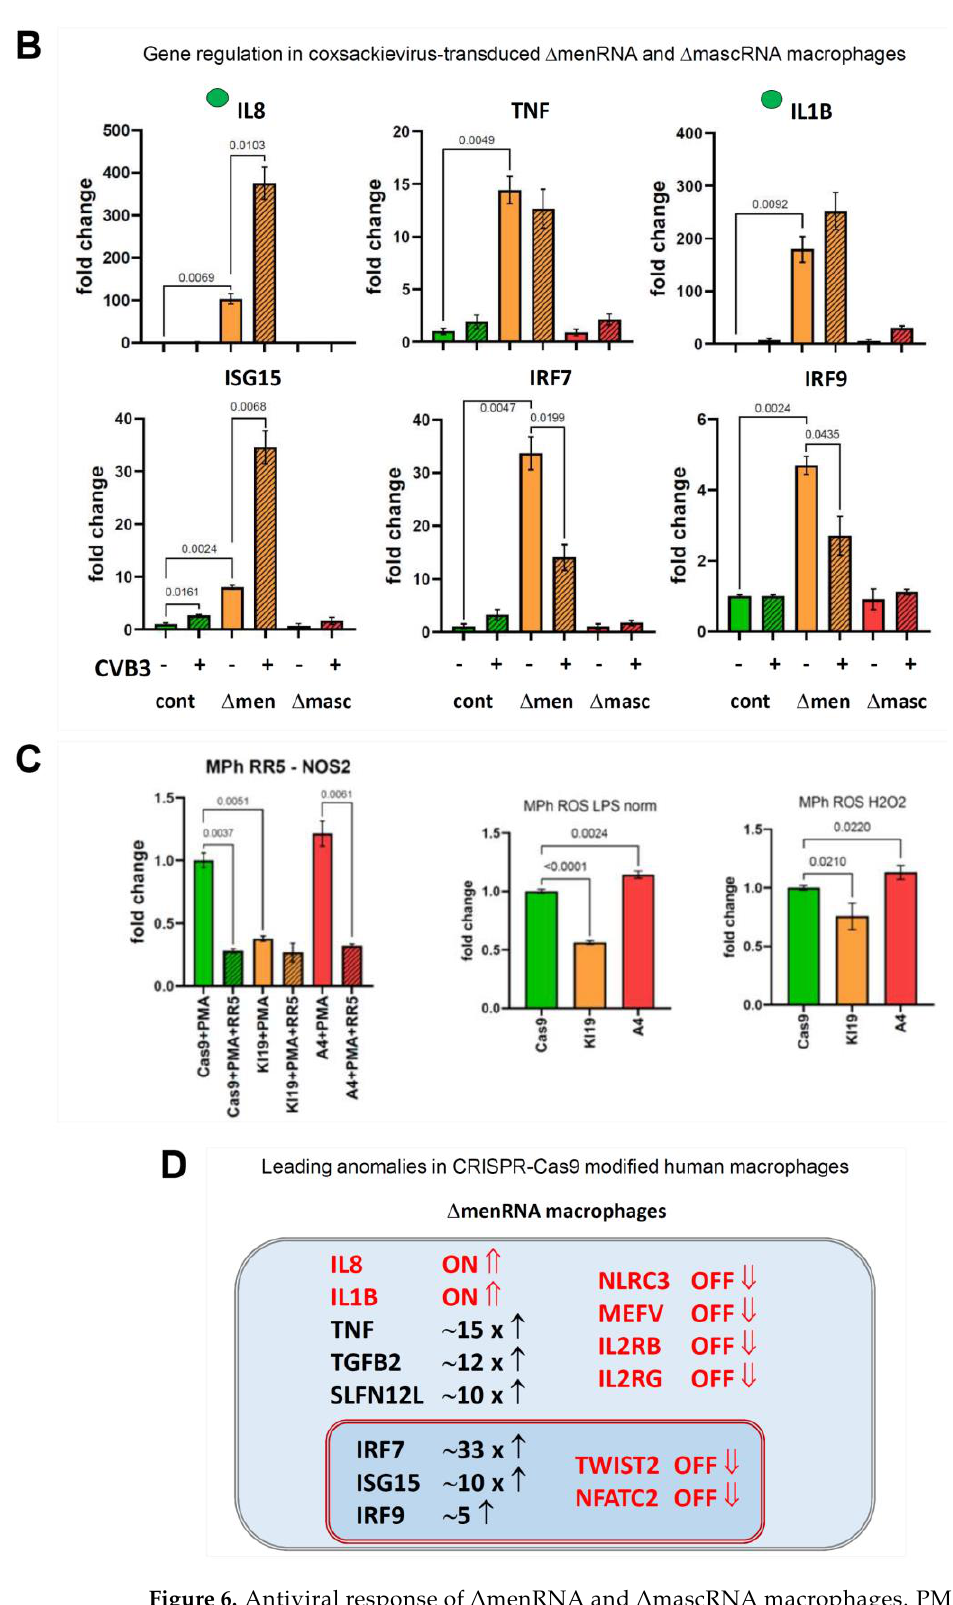
Figure 6. Antiviral response of ∆ menRNA and ∆ mascRNA macrophages. PMA-induced differ- entiation of ∆ menRNA cells to adherent macrophages rendered the cells susceptible to efficient transduction by recombinant viruses derived from the human-pathogenic double-stranded DNA (dsDNA) adenovirus type 5. At a multiplicity of infection (MOI) of 25, the GFP-expressing virus AdV-CMV-GFP efficiently transduced these macrophages, resulting in strong GFP expression